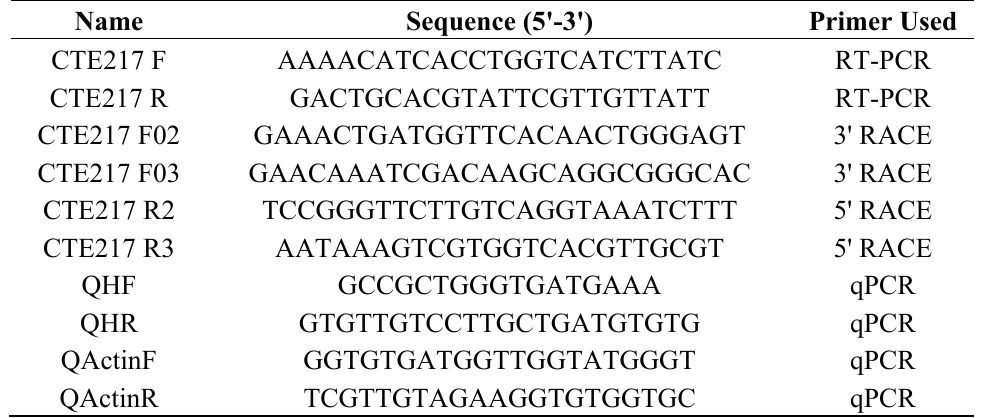
Table 1. Primers used in PCR amplification and RACE reaction.